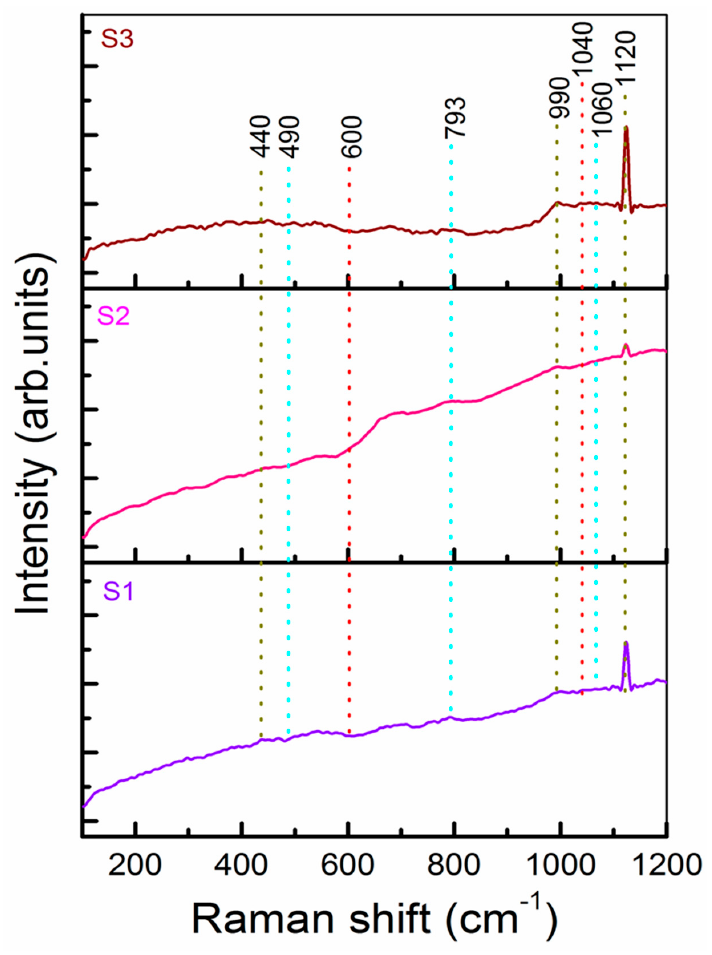
Figure 4. Spectra of S1, S2, and S3 nanopowders.